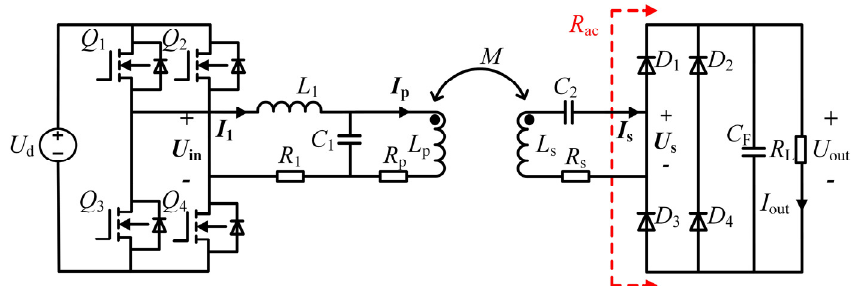
Figure 2. Circuit diagram of the LC/S compensated IPT system.